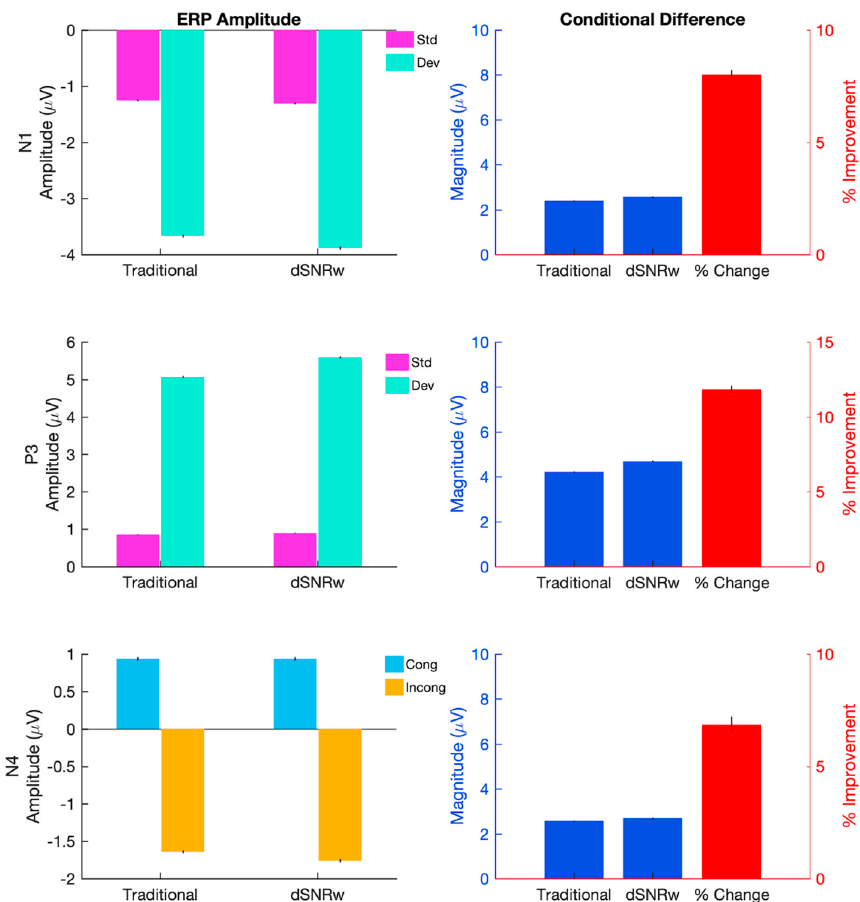
Figure 6. ERP amplitude measurements for N100, P300 and N400 ERPs, presented mean ± SEM. Left: ERP signal amplitude in time windows of interest, shown as shaded intervals in previous figure, for ERPs derived from traditional and dSNRw weighted pooling schemes. All pairwise p ’s < 0.001. Right: The magnitude of the difference among experimental conditions for each channel pooling technique, as well as the relative percentage change. Pairwise comparisons of magnitude differences for each ERP: p < 0.001. Traditional, dSNRw = channel pooling techniques; Std = standard tonal stimuli, Dev = deviant tonal stimuli, Cong = congruent word stimuli, Incong = incongruent word stimuli; N1 = N100 ERP, P3 = P300 ERP, N4 = N400 ERP.